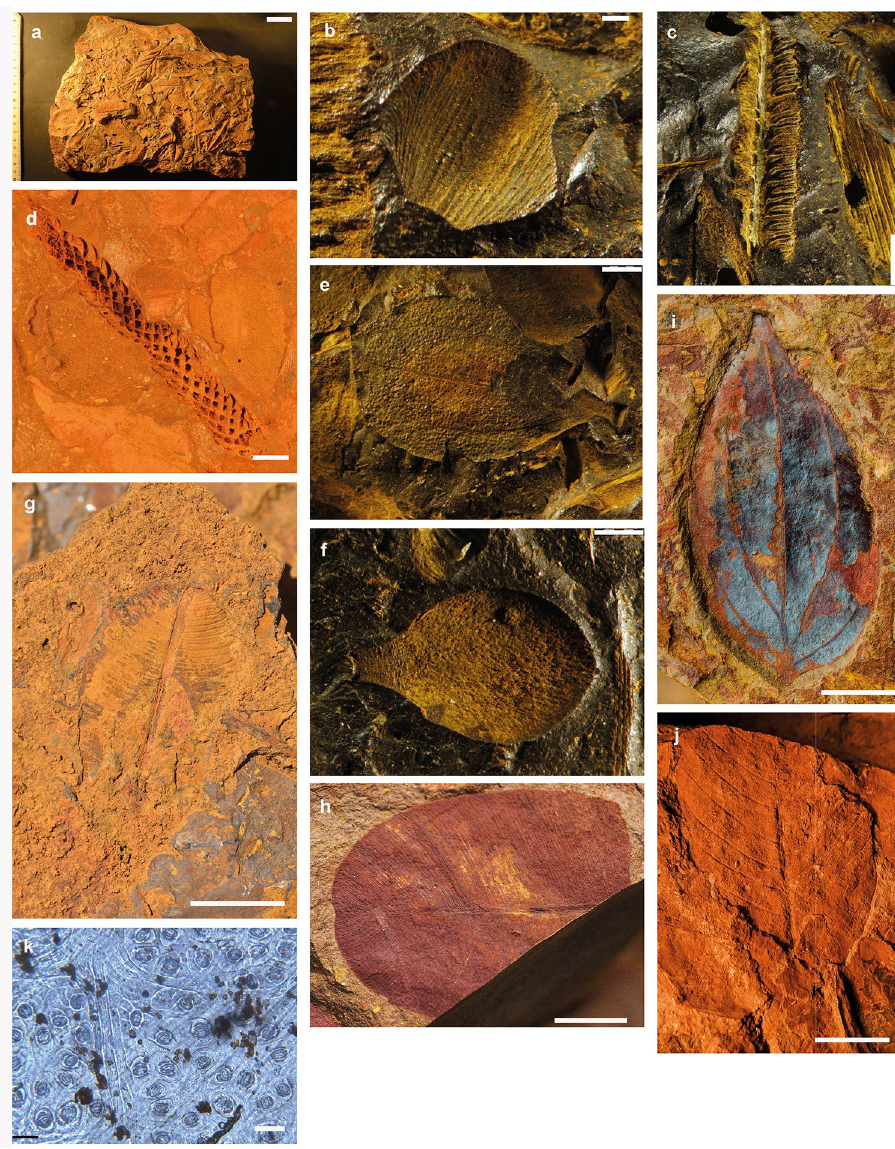
Figure 3. Middle(?) Miocene plants. ( a–f ) La Madeleine outcrop; ( g–j ) Pont des Japonais outcrop. ( a ) Mad_1 from Madeleine showing the very dense fossils assemblage; ( b ) inflorescence bract of Styphelia sp. (Ericaceae ex-Epacridaceae), Mad_1_A_Fe142; ( c ) fern pinnule, Mad_1_Fe49; ( d ) axis with 48 leaves of cf. Dacrydium sp. (Podocarpaceae), Mad_17_A_Axe1; ( e ) leaf of Melaleuca sp. (Myrtaceae), Mad_1_A_Fe171; ( f ) probable petal of dicotyledon, Mad_1_A_Peta115; ( g ) leaf of Solmsia sp. (Thymelaeaceae), Mad_22_A_Fe1; ( h ) leaves of Calophyllum cf. caledonicum (Calophyllaceae), Pjap_21_A; ( i ) leaf very similar to that of an extant species of Cryptocarya (Lauraceae), Pjap_46_A_Fe1; ( j ) leaf of Alphitonia cf. caledonica (Rhamnaceae), Pjap_55_A_Fe2; ( k ) imprint of Mad_6_Fe1 showing epidermis and stomata (same type of leaf as specimen figured in 3i). Copyright J. Munzinger ( a, h, i ); Copyright Thibault Chaillon ( b-f ); Copyright R. Garrouste ( g ); Copyright Wyndy Foy ( j,k ). Scale bars ( b ) & ( f ) = 1 mm; ( e ) & ( c ) = 2 mm; ( d ) = 5 mm; ( k ) = 50